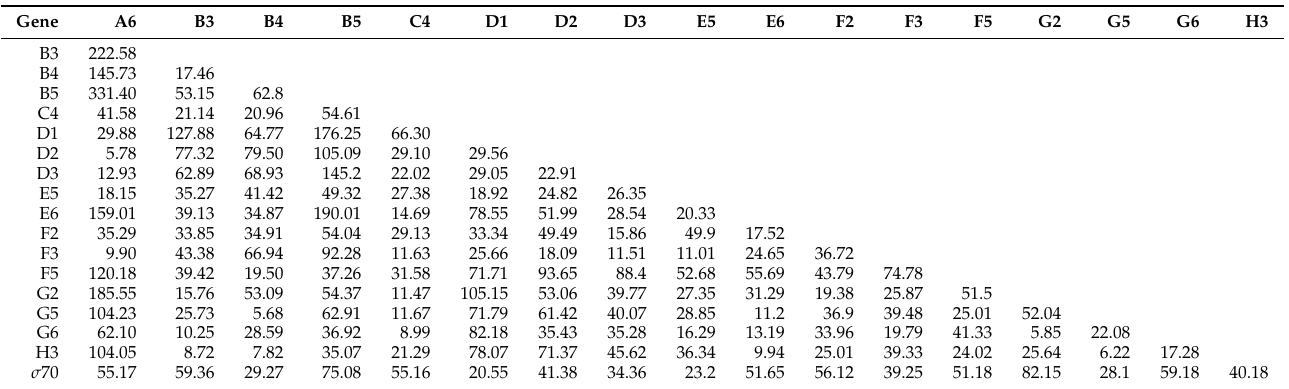
Figure 20. The clustering tree of 18 genes in P. aeruginosa . Table 6. Mahalanobis distance between